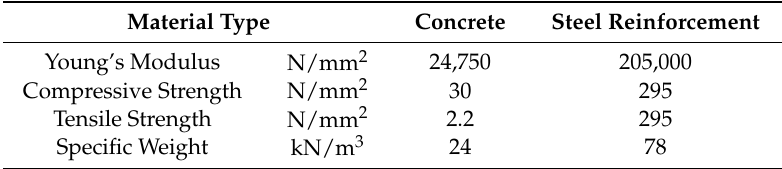
Table 1. Material properties of the referential target reinforced concrete (RC)